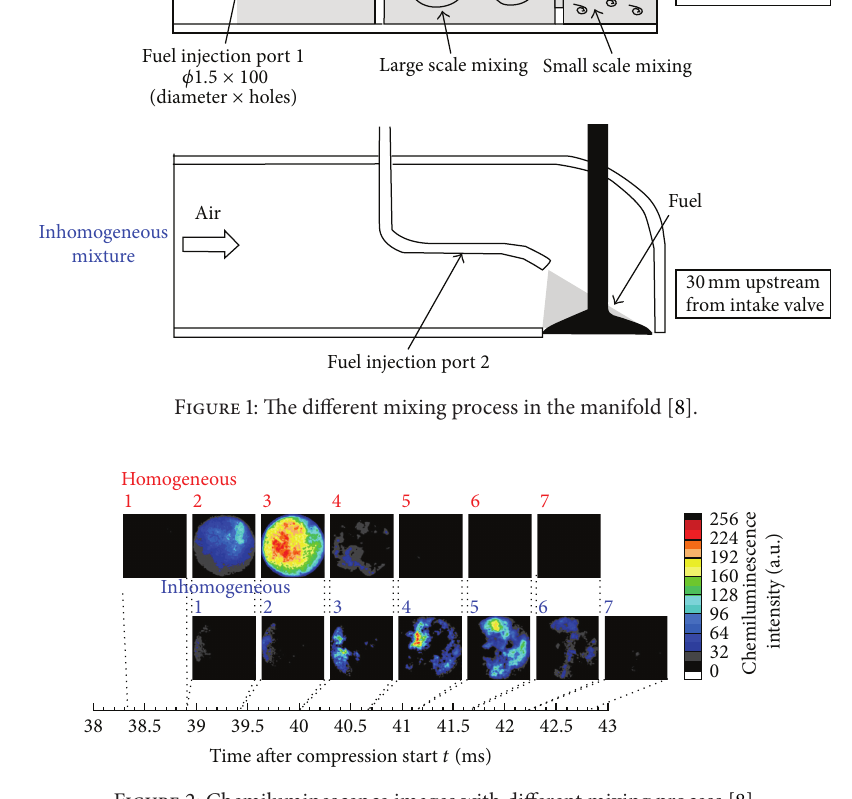
Figure 2: Chemiluminescence images with different mixing process